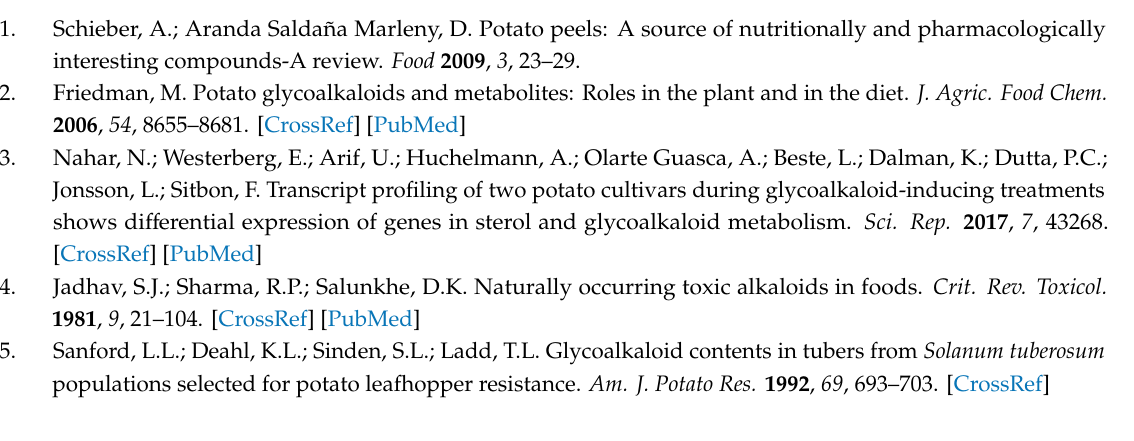
Table S1, primers used for qRT-PCR in the present study. Table S2, summary of sequencing and mapping data from four indicated time points. Table S3, the detail expression data of all DEGs comparing control samples. Table S4, genes of SGAs biosynthesis and disease resistance used for Weighted gene co-expression network analysis (WGCNA). Figure S1, weighted gene co-expression network analysis (WGCNA) of potato. Figure S2, the correlation between modules and di ff erent